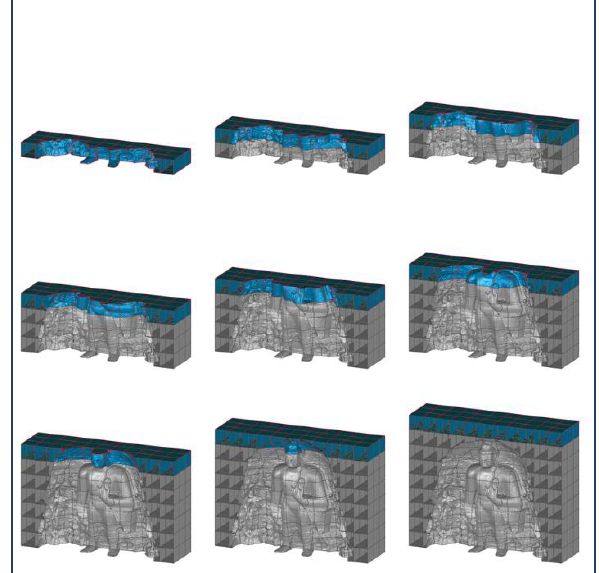
Figure 9. Reproduction method simulation